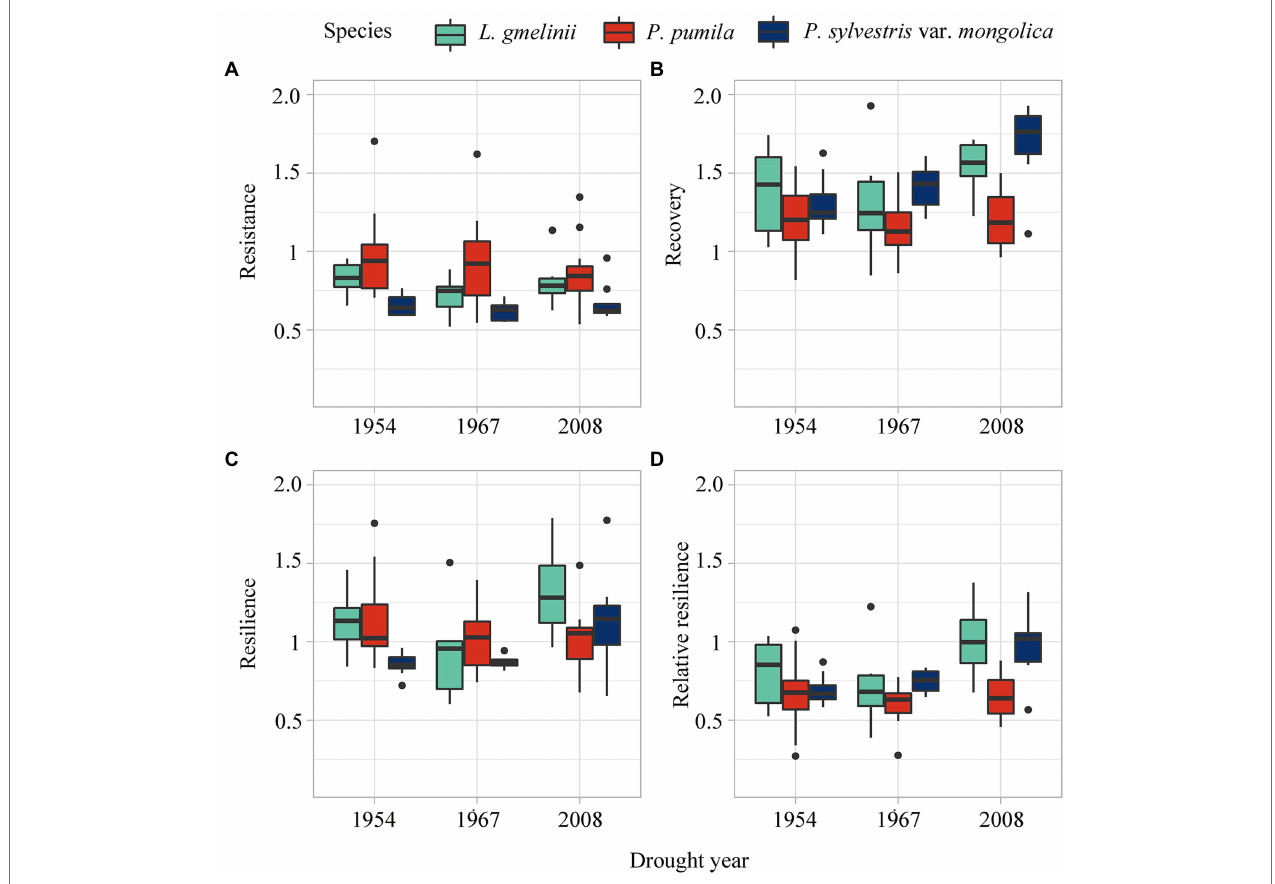
FIGURE 6 | Resistance (A) , recovery (B) , resilience (C) , and the relative resilience (D) of L. gmelinii , P. pumila and P. sylvestris var. mongolica response to three drought